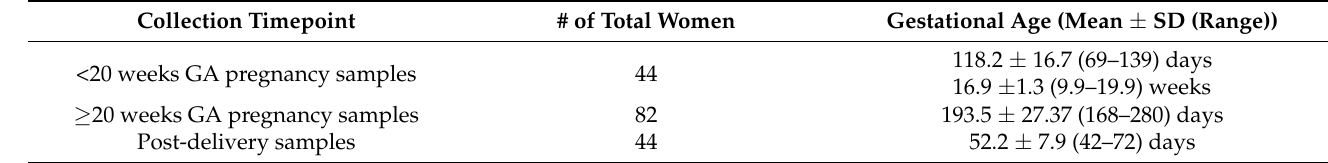
Table 2. Mean gestational age at each swab